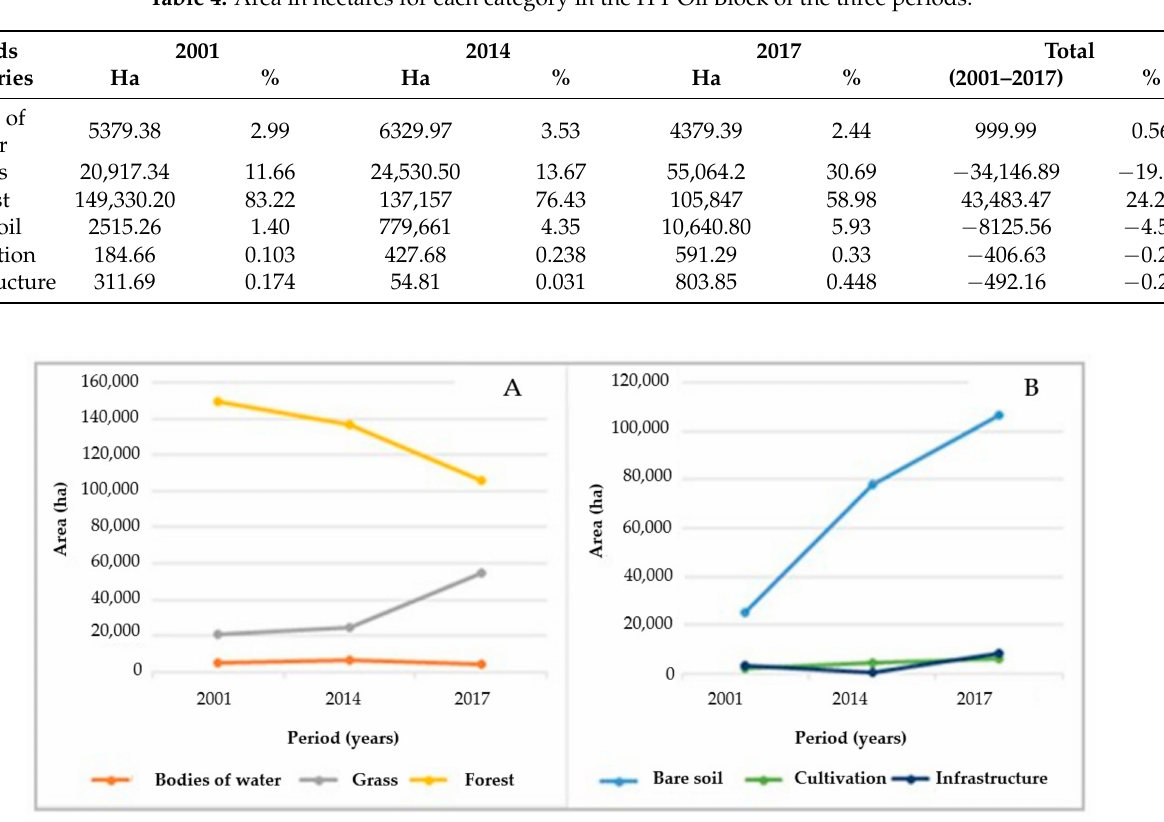
Figure 6. Spatial dynamics of the categories: ( A ) Bodies of water, grassland, and forest; ( B ) bare soil, cultivation, and infrastructure in the ITT Oil